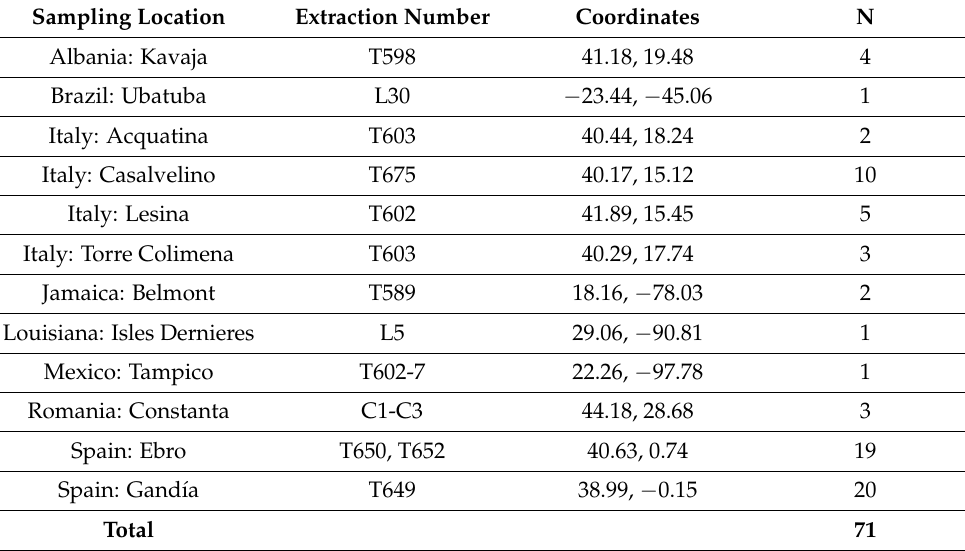
Table 1. Collection sites, extraction numbers, coordinates (latitude, longitude), and number of newly analyzed samples of Callinectes sapidus